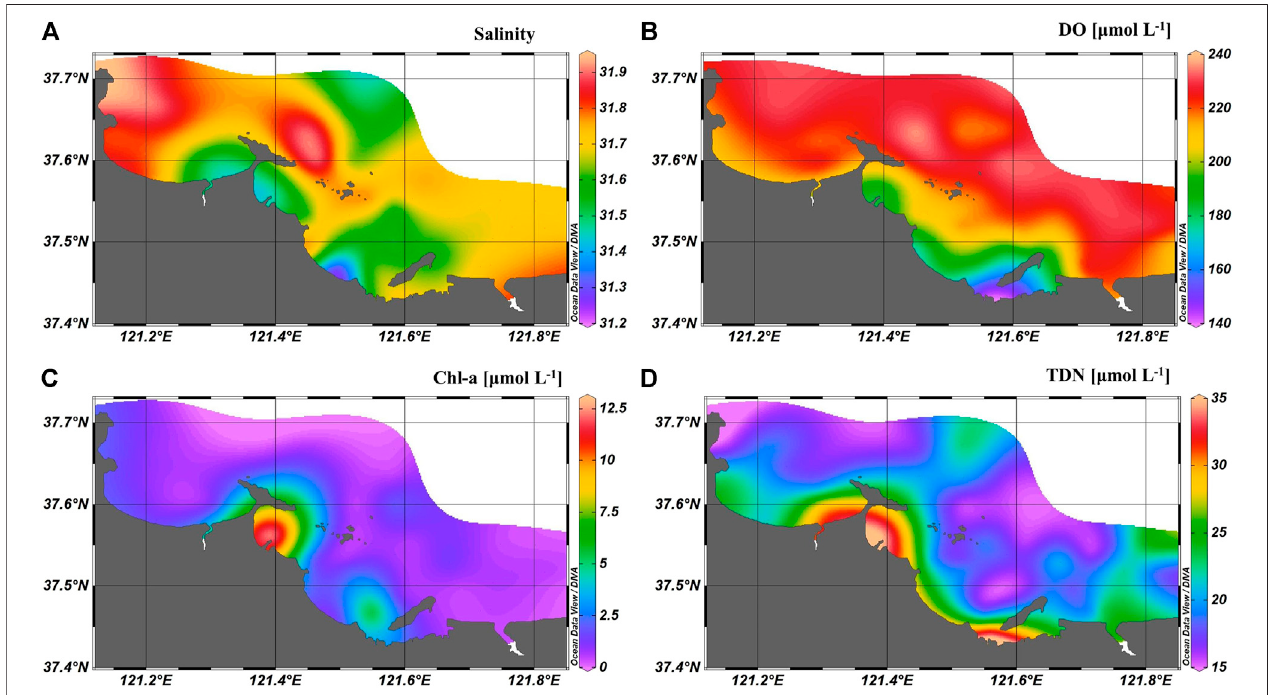
FIGURE 3 | Surface distribution of salinity (A) , DO (B) , Chl-a (C) , and TDN (D) in Sishili Bay and Taozi Bay. This fi gure was made in ODV using DIVA gridding.